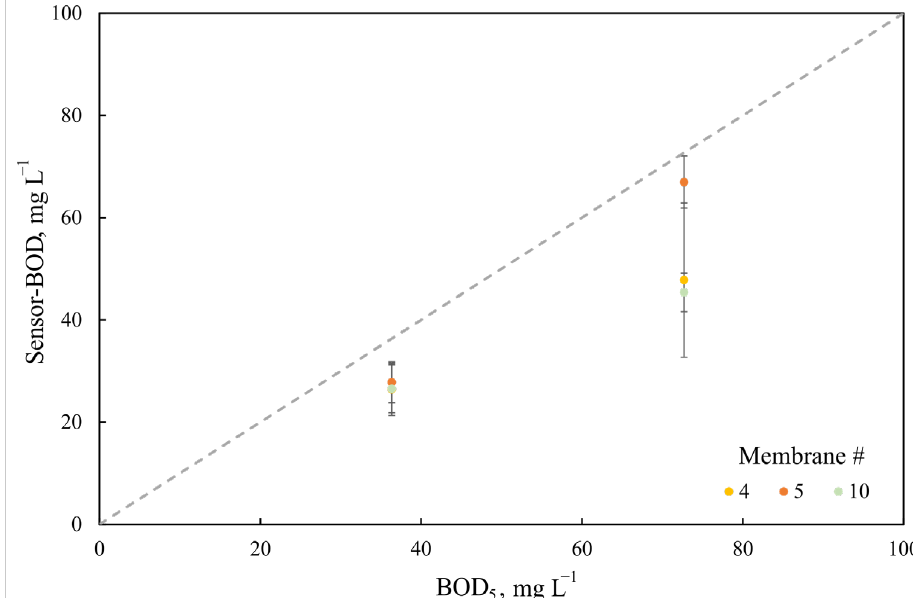
Fig. 10. Comparison of BOD 5 and sensor-BOD, where dashed line shows 1 to 1 correlation between BOD 5 and